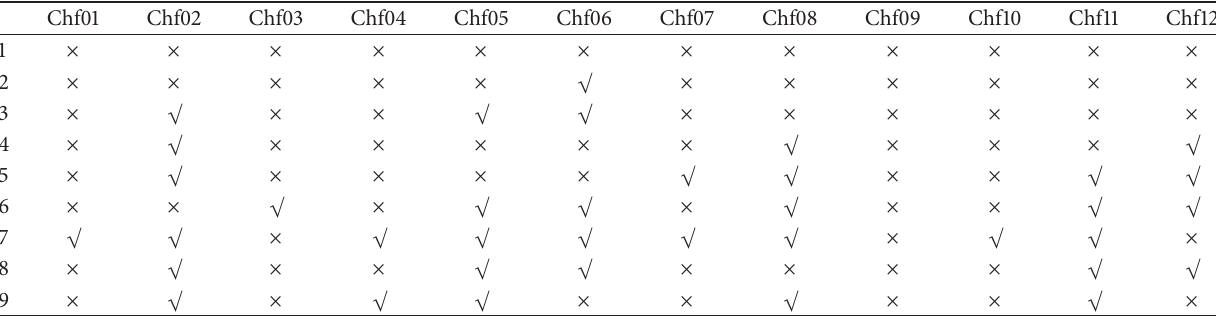
Table 2: Detection results of FTF under different conditions and directions.